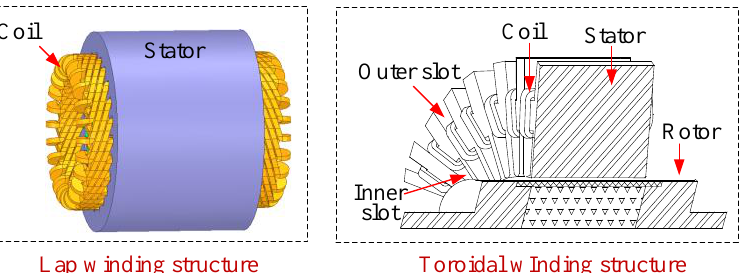
Figure 9. End length comparison between toroidal winding and conventional